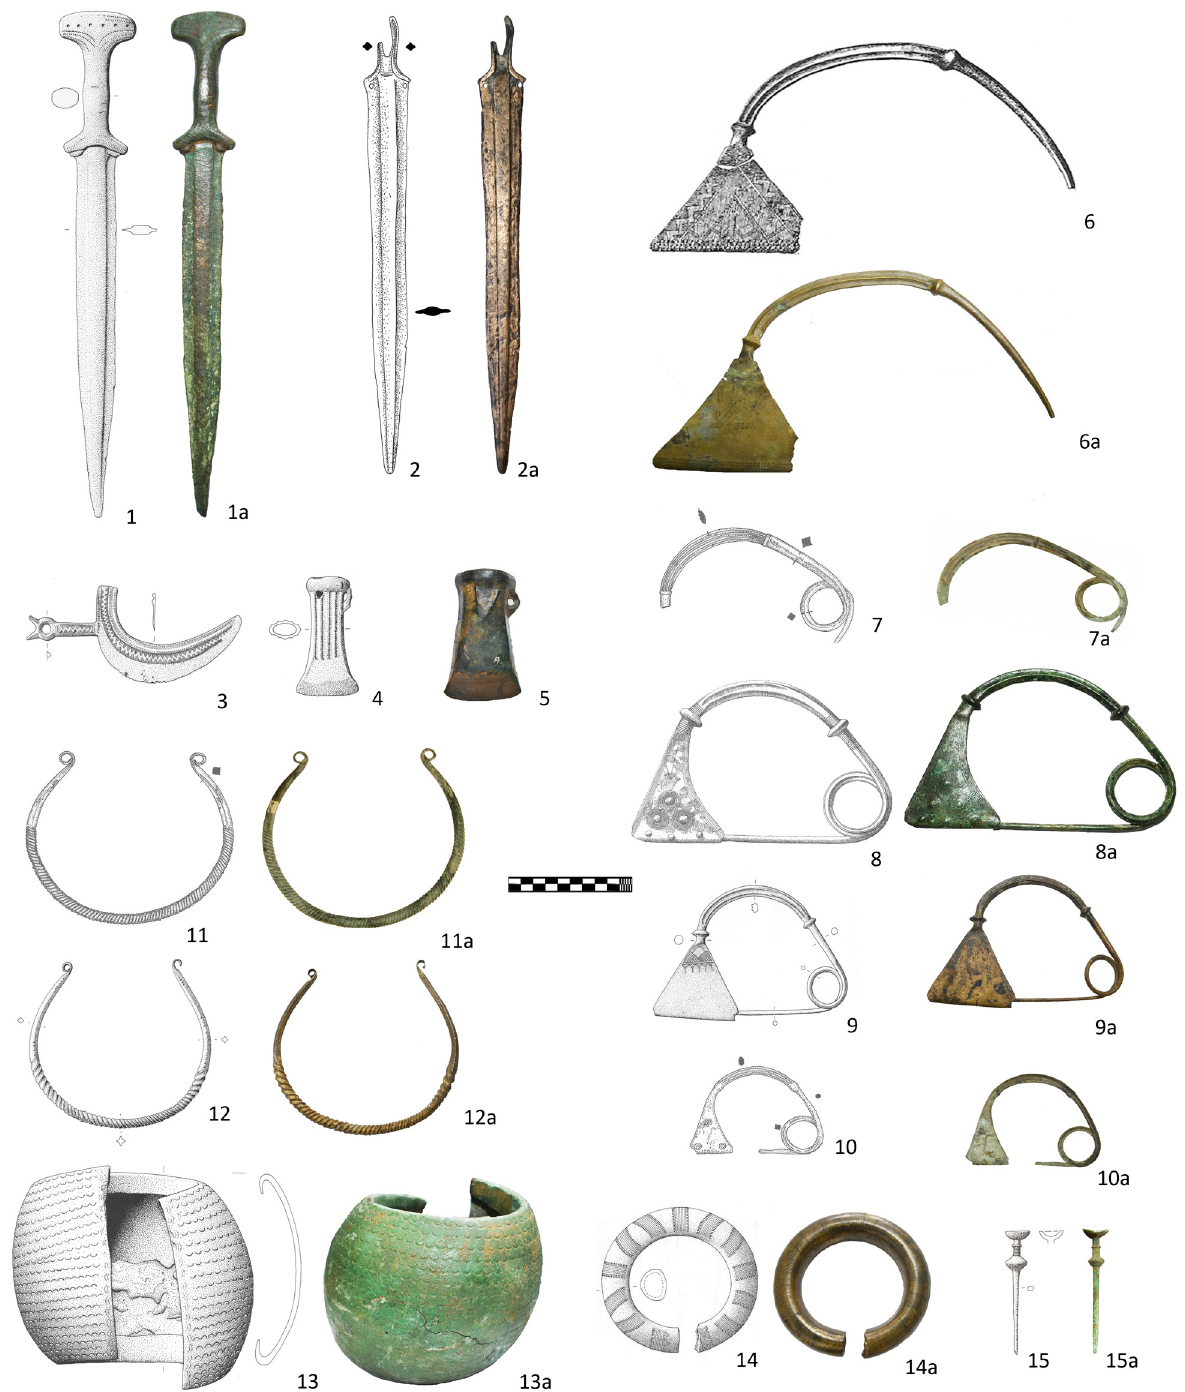
Fig 4. Group 3 of sampled metal object (Ha B3). 1. Pakline; 2. Ilijasˇ; 3–4: Grapska; 5. Prozor; 6. Ivanjska; 7. 10. 12: Travnik; 8: Gradac Sokolac; 9.12: Vitina-Otok; 13: Veliki Mosˇunj; 14: Hrge-Lu č ica; 15: Milci (1: reprinted from [41] under CC BY license with permission from A.